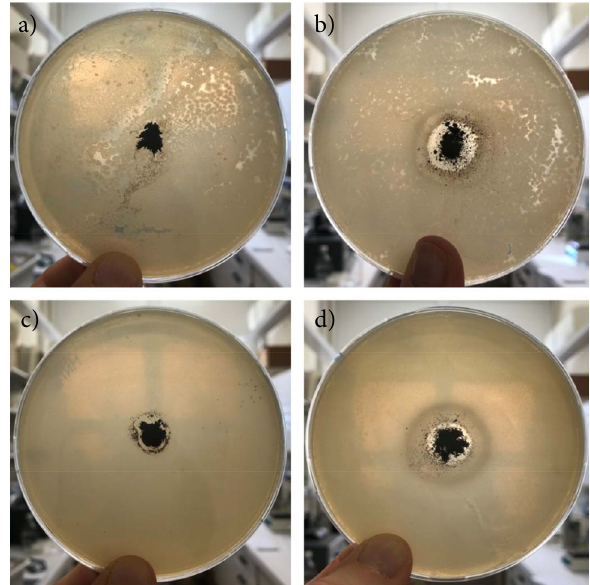
Figure 1 . Uncoated MNPs on bacterial culture E. coli after incuba- tion at 37 °C for 24 hours (a), CMD-MNPs on bacterial culture E. coli after incubation at 37 °C for 24 hours, where inhibition zone can be seen (b), uncoated MNPs on bacterial culture S. aureus after in- cubation at 37 °C for 24 hours (c) and CMD-MNPs on bacterial culture S. aureus after incubation at 37 °C for 24 hours, where inhi- bition zone can be seen